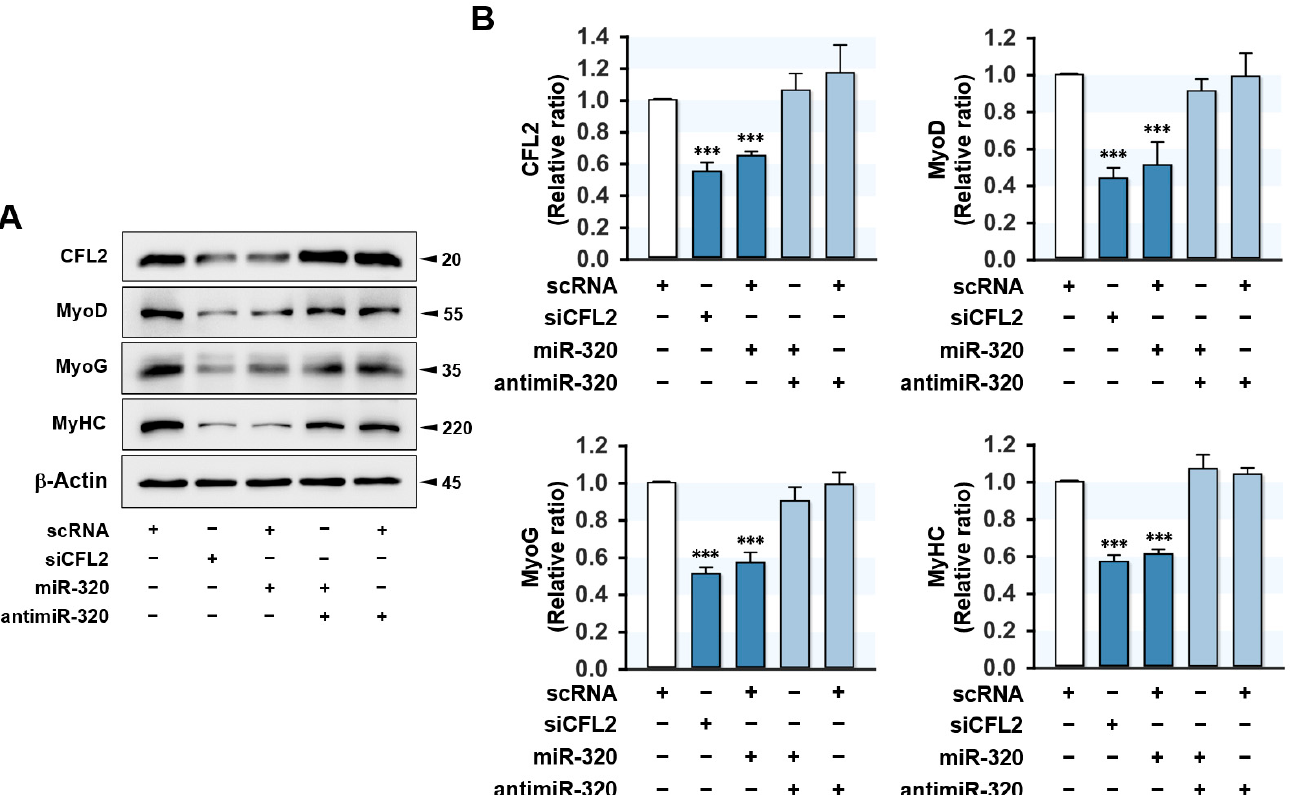
Figure 5. MiR-320-3p inhibited myogenic factors expressions. Cells were transfected with scRNA, siCFL2, miR-320-3p mimic (miR-320), or antimiR-320-3p (antimiR-320) and differentiated for 3 days. ( A ) Immunoblotting analysis of myogenic factors, such as MyHC, MyoD, MyoG, and CFL2. ( B ) The values between panels indicate relative protein levels normalized against β -Actin. Results are means ± SEMs ( n > 3). ***, p < 0.001 vs. scRNA control.